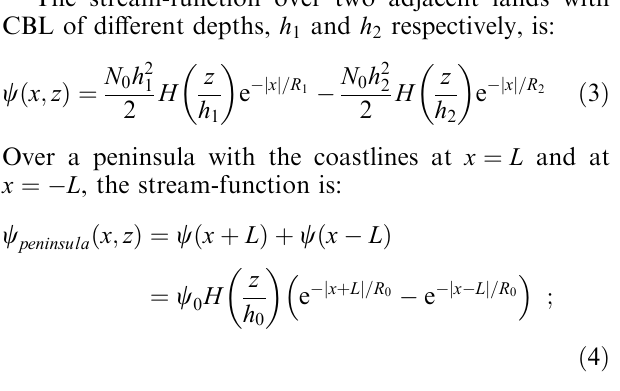
The mean sea-breeze intensity (cid:22) U is the square root of 2MAPE divided by the volume, 2 (cid:133) R (cid:135) L (cid:134) h the adiabatic redistribution of air masses: